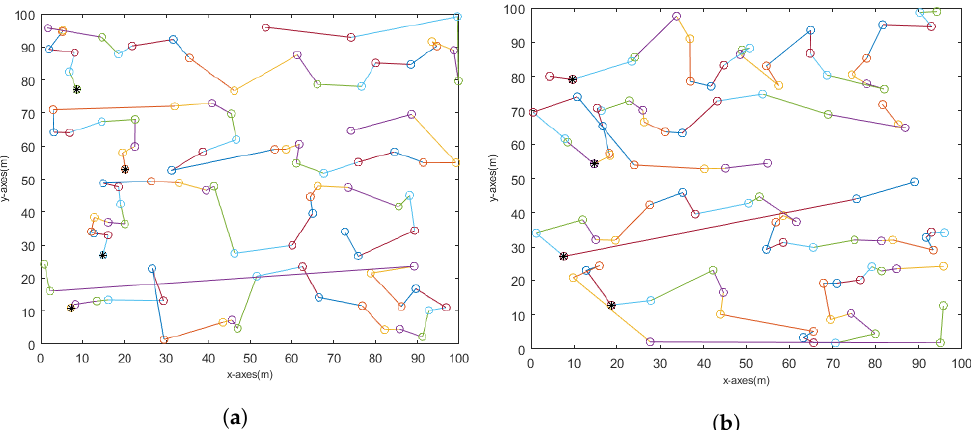
Figure 17. Multi-chain single-hop formation: (nodes are represented using different colors, while (cid:107) represents the CH). ( a ) D-Chain, ( b ) Q-Chain.